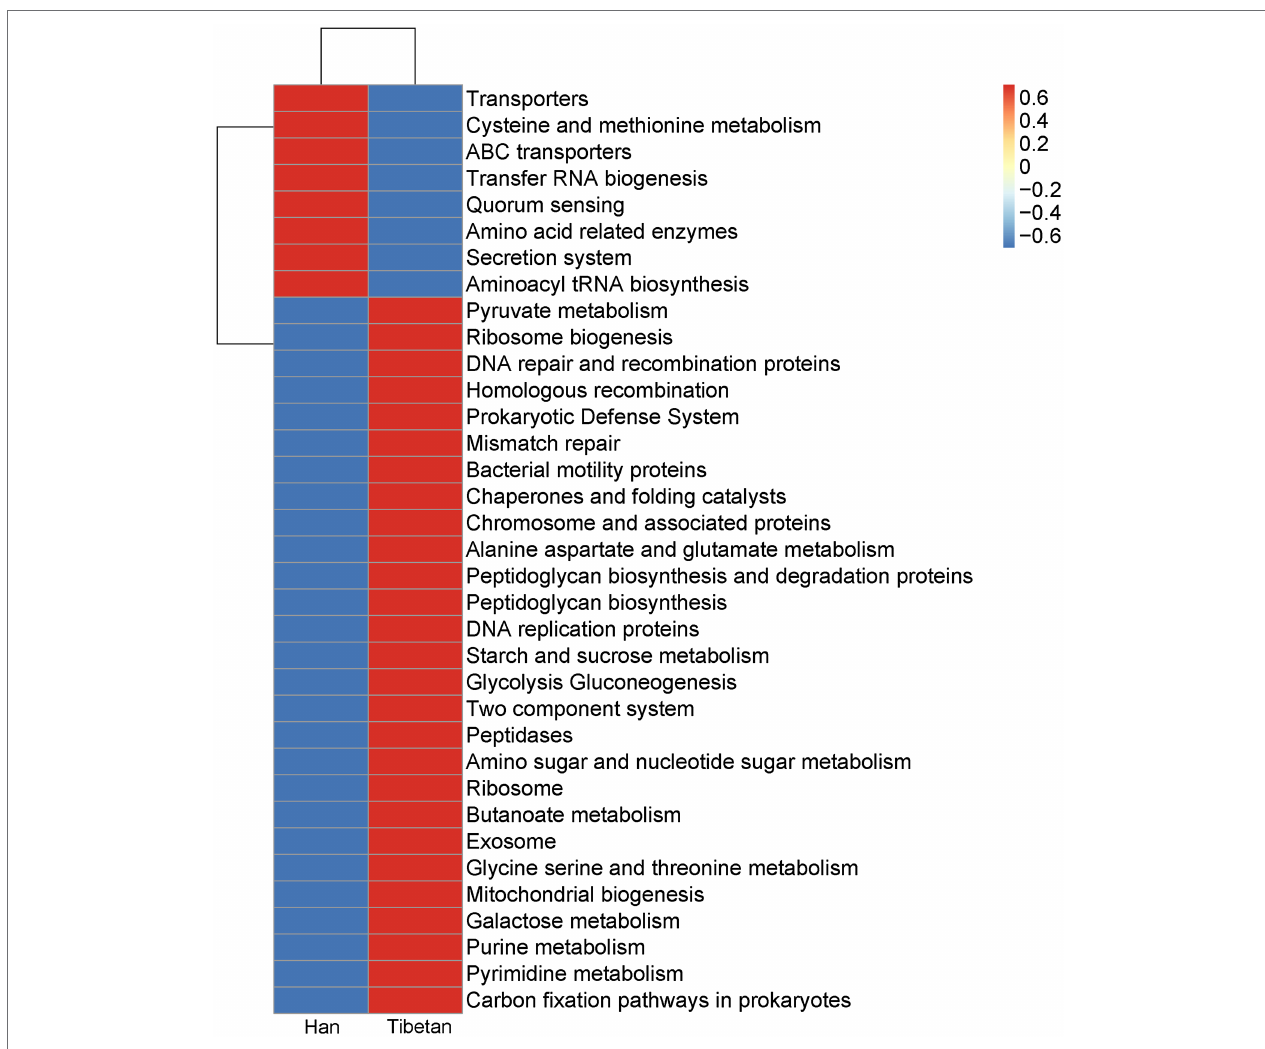
FIGURE 6 | Functional profiles of the fecal microbial communities in native Tibetans and Han immigrants. The 35 most-abundant pathways at the third level of KEGG pathways are shown in a